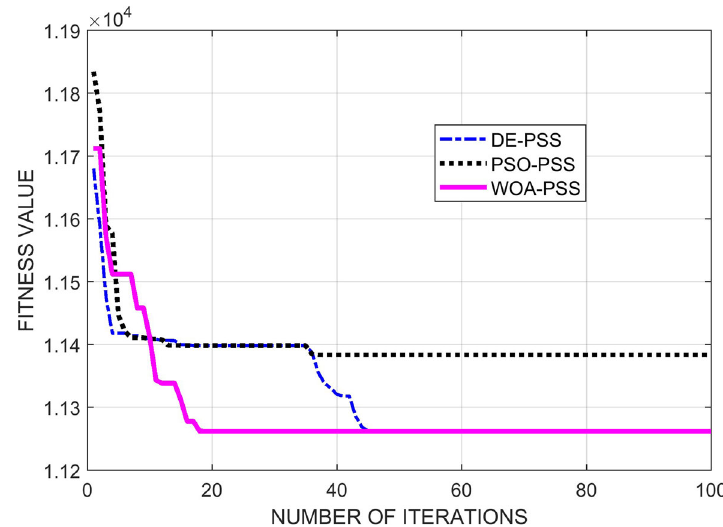
Fig. 20 convergence characteristics WOA,DE and